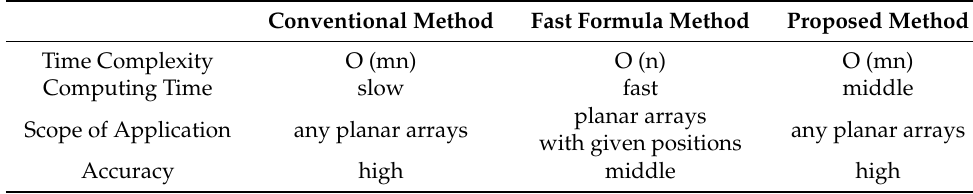
Table 4. The comparison of the proposed method with other